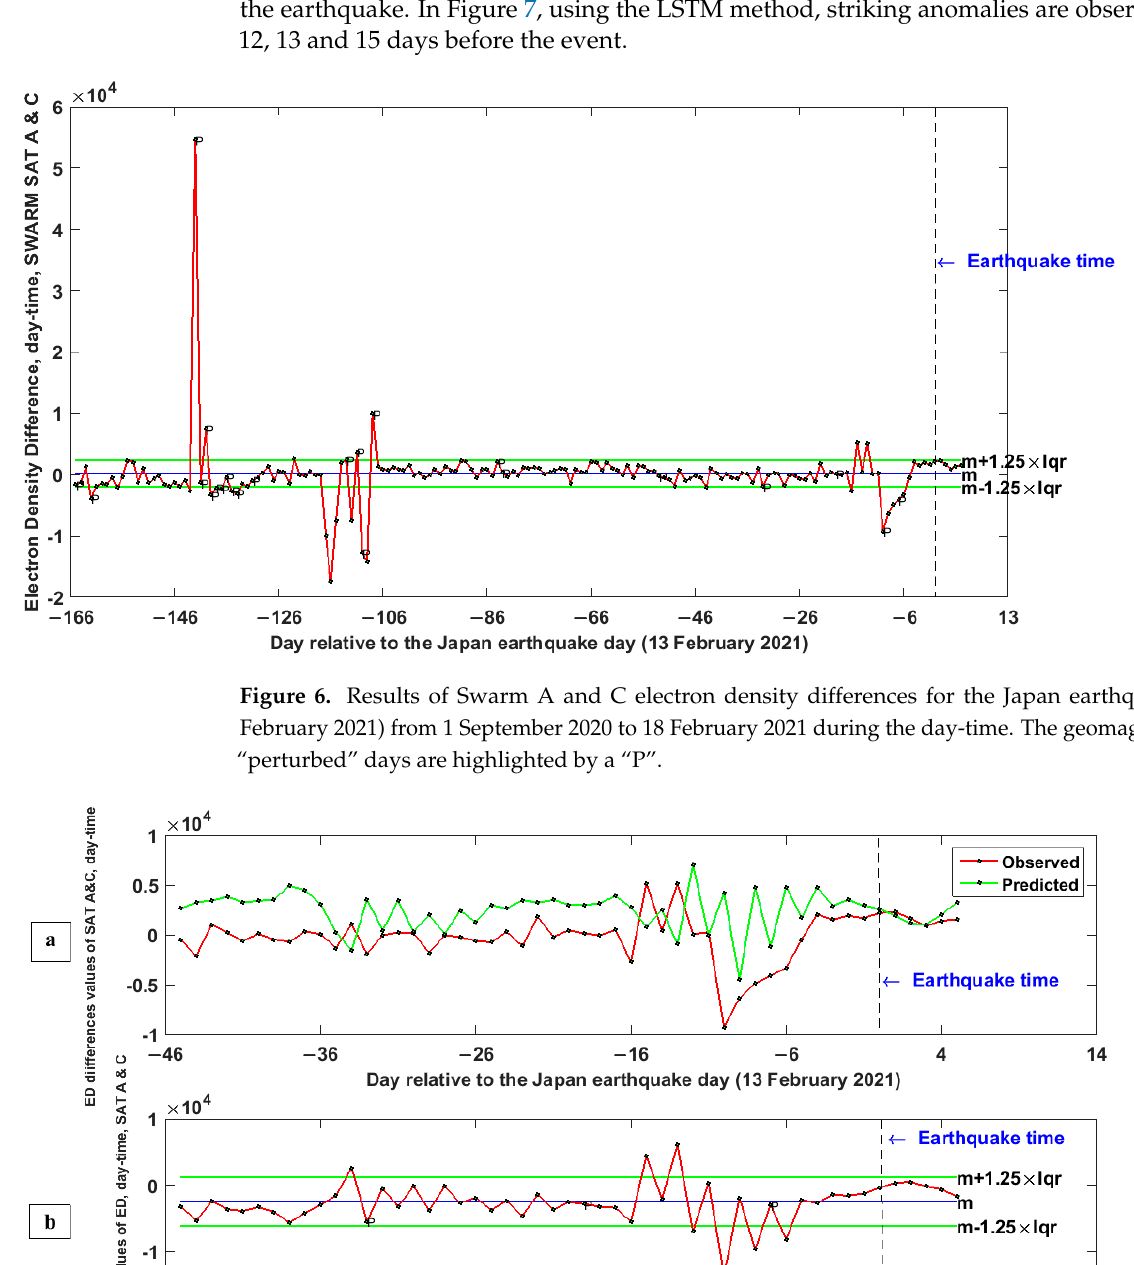
8 of 21 indicate the upper and lower bounds as 𝑚 ± 1.25 × 𝐼𝑞𝑟 . The blue horizontal line indicates the me-